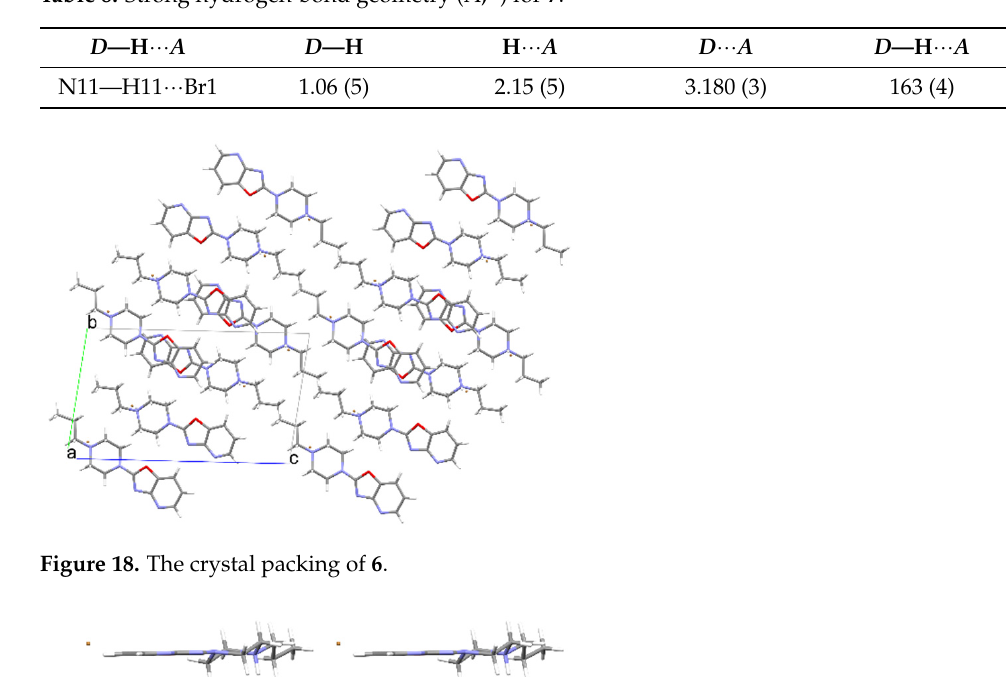
Table 8. Strong hydrogen-bond geometry (Å, º) for 7 .